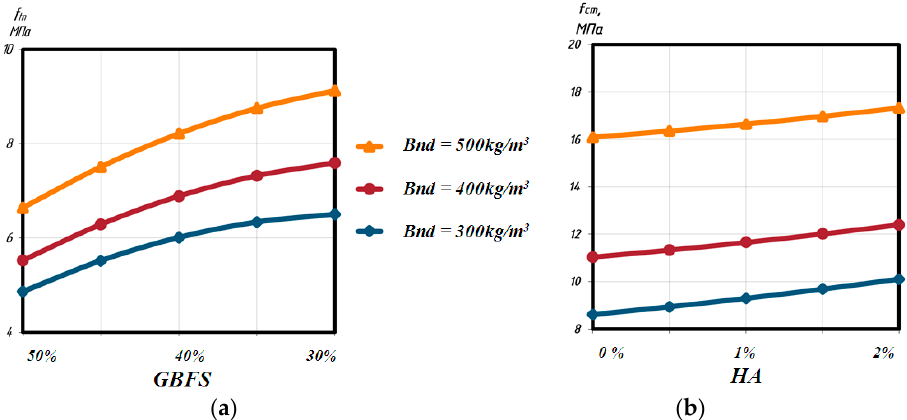
Figure 4. Graphical dependences of structural strength after 10 min ( a ) and 40 min ( b ) of mixture curing.